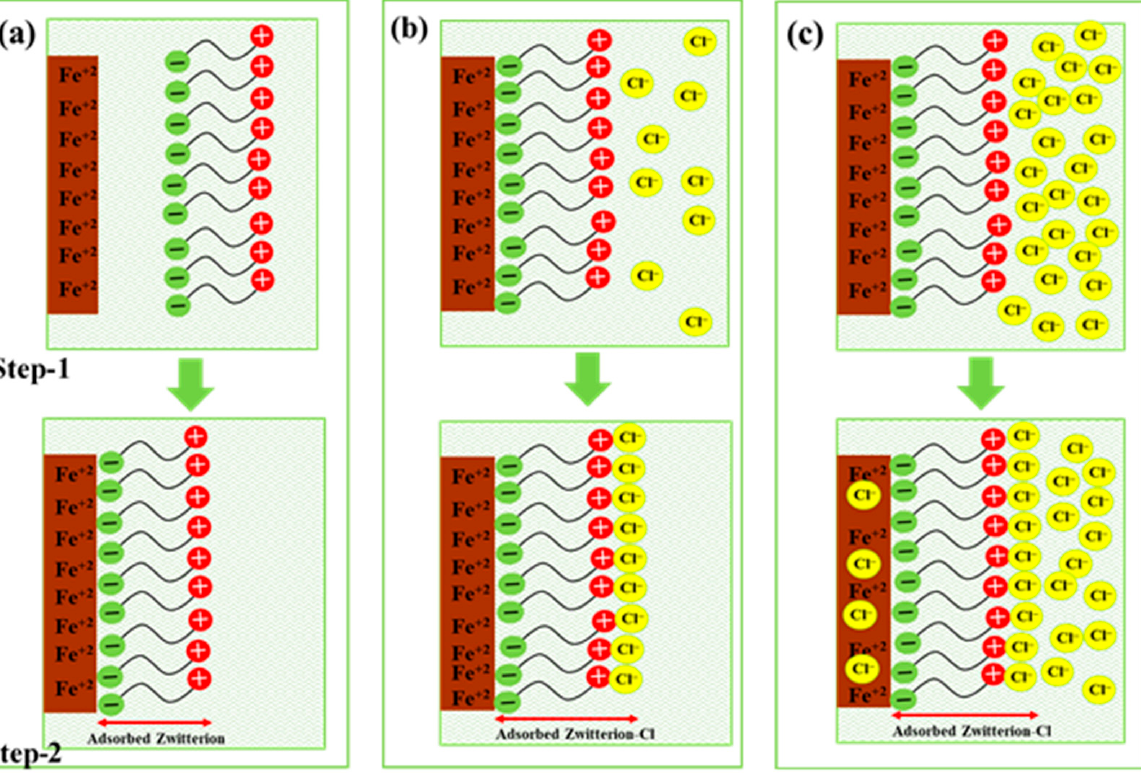
Figure 9. Schematic of ( a ) SP-0 for formation of Zwitterion–Fe complex as passive film, ( b ) interaction of Cl − ions with passive film in SP-1, and ( c ) SP-2 solutions onto the steel rebar surface.